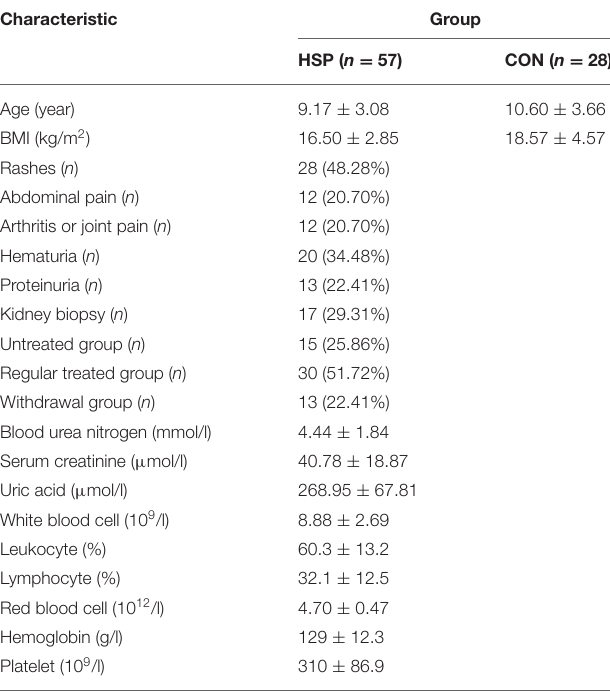
TABLE 1 | Clinical characteristics of the